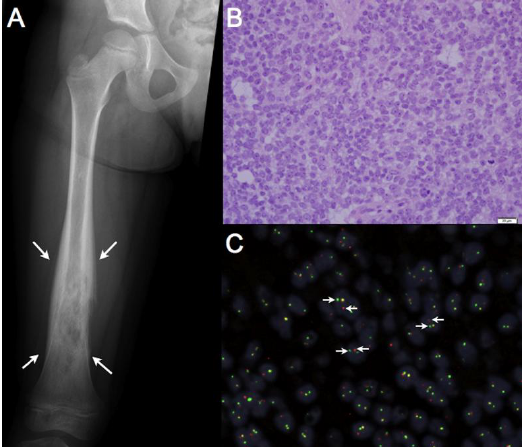
Figure 1. Ewing sarcoma is an aggressive bone associated malignancy characterized by chromosomal translocations. ( a ) Classic radiographic appearance of Ewing sarcoma: an expansile, destructive lesion (outlined by white arrows) of the femoral diaphysis (shaft) in a skeletally immature patient. Ewing sarcomas can also present as an isolated soft tissue mass, although this is less common; ( b ) 400× magnification of a Hematoxylin and Eosin (H & E) stained section from a Ewing sarcoma tumor. Microscopically, these tumors are characterized by sheets of small round cells with a high nuclear-to cytoplasmic ratio; ( c ) Break-apart Fluorescence in situ Hybridization (FISH) showing EWSR1 rearrangements in 84% of tumors cells, confirming the diagnosis of Ewing sarcoma. Dual, non-overlapping, (cid:24)(cid:182) - EWSR1 (cid:83)(cid:85)(cid:82)(cid:69)(cid:72)(cid:86)(cid:3)(cid:11)(cid:85)(cid:72)(cid:71)(cid:12)(cid:3)(cid:68)(cid:81)(cid:71)(cid:3)(cid:22)(cid:182) - EWSR1 probes (green) detect the presence of a chromosomal rearrangement; when the red and green probes are split into two distinct signals (white arrows) a chromosomal rearrangement is identified, whereas an orange signal indicates an intact EWSR1 locus.